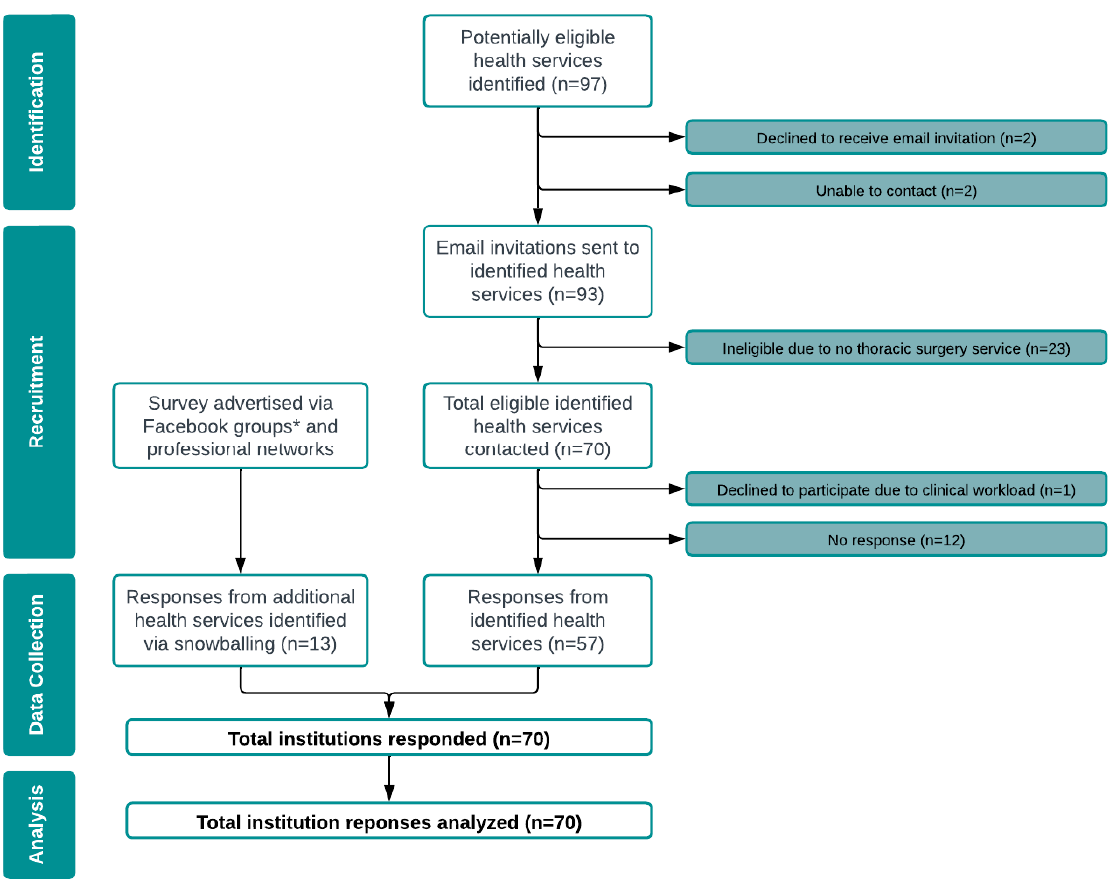
Figure 1. Flow of invited and snowballed health services throughout the study. * Australian Physiotherapy Association (APA) Cardiorespiratory Group; APA Cancer, Palliative Care and Lymphoedema Group; Exercise and Sport Science Australia (ESSA) Cardiovascular Group; ESSA Cancer Group; and Pulmonary Rehabilitation Network.